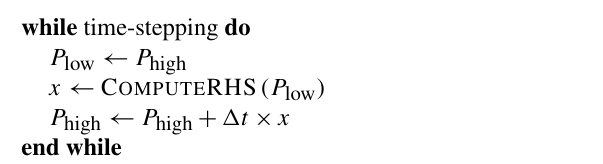
Algorithm 3 Time stepping of a prognostic variable with mixed precision using a simple forward-in-time